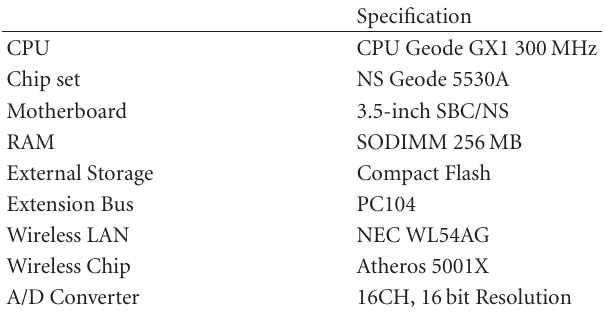
Table 2: Hardware specifications of a wireless